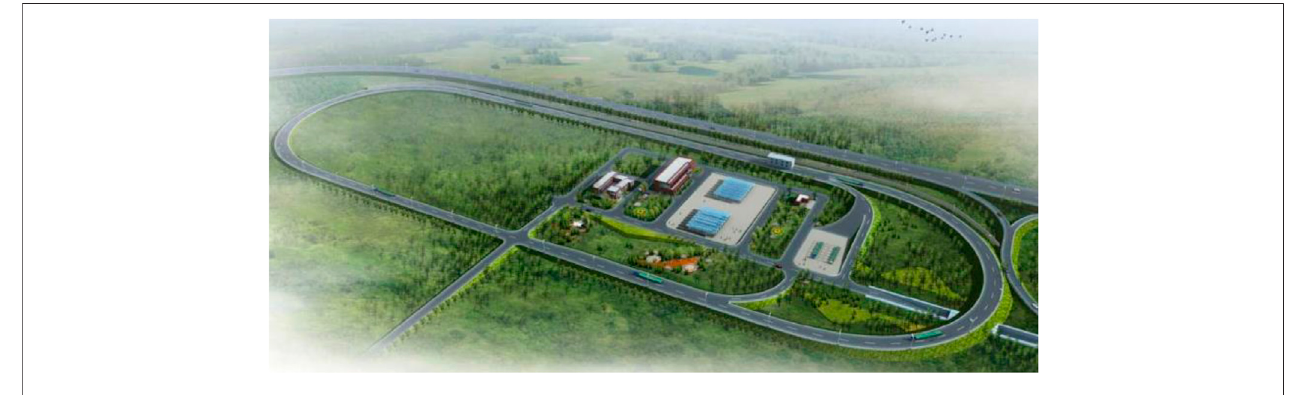
FIGURE 1 | Effect diagram of RIOHTrack.